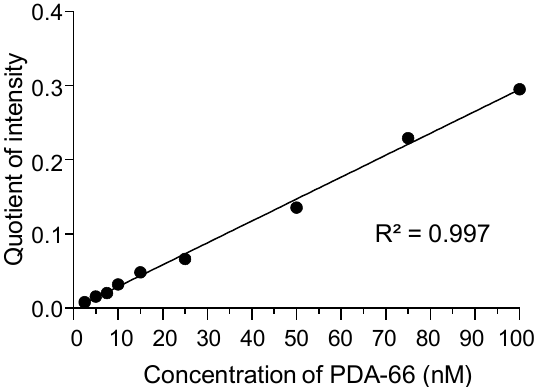
Figure 2. Sample calibration function, in which the quotient of the area of the quantifiers m/z 317.1 (PDA-66) and m/z 250.1 (internal standard) was formed at the indicated concentrations.